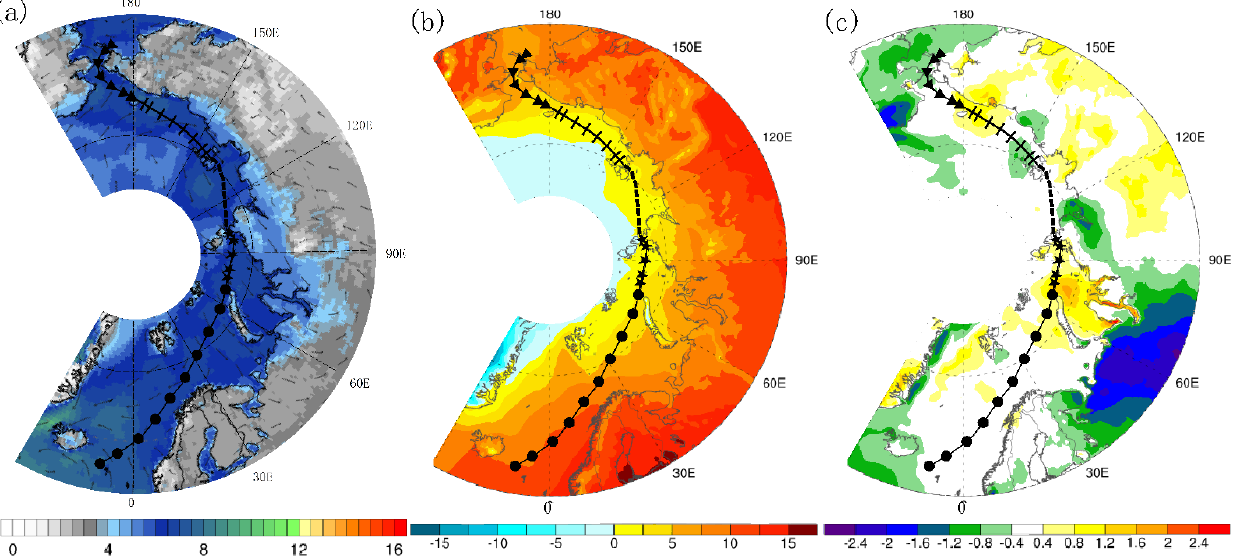
Figure 22. The average wind field ( a ), average temperature ( b ) and temperature anomalies ( c ) of the NEP in the Arctic summer in